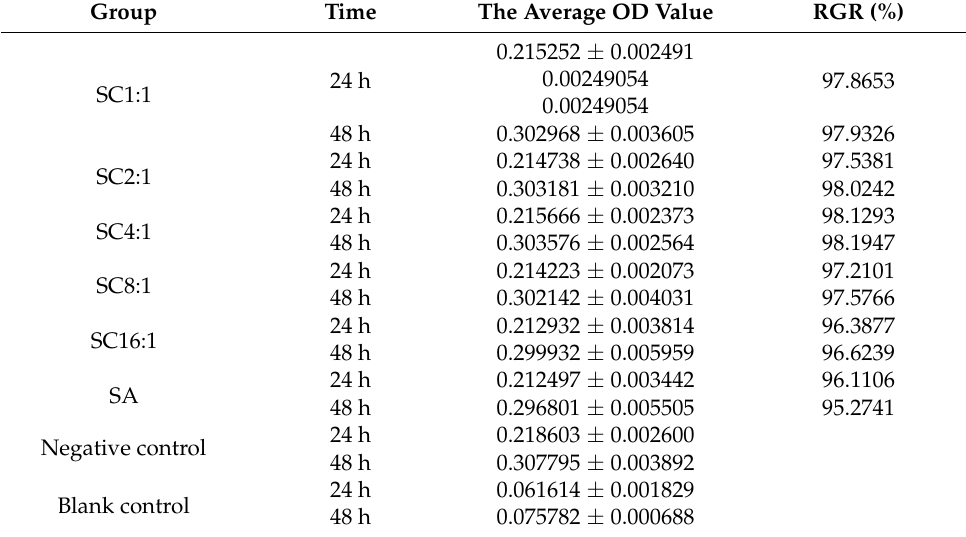
Table 2. Average OD values and RGR values at different time points in each group. Each value represents the mean ± S.D. ( n =